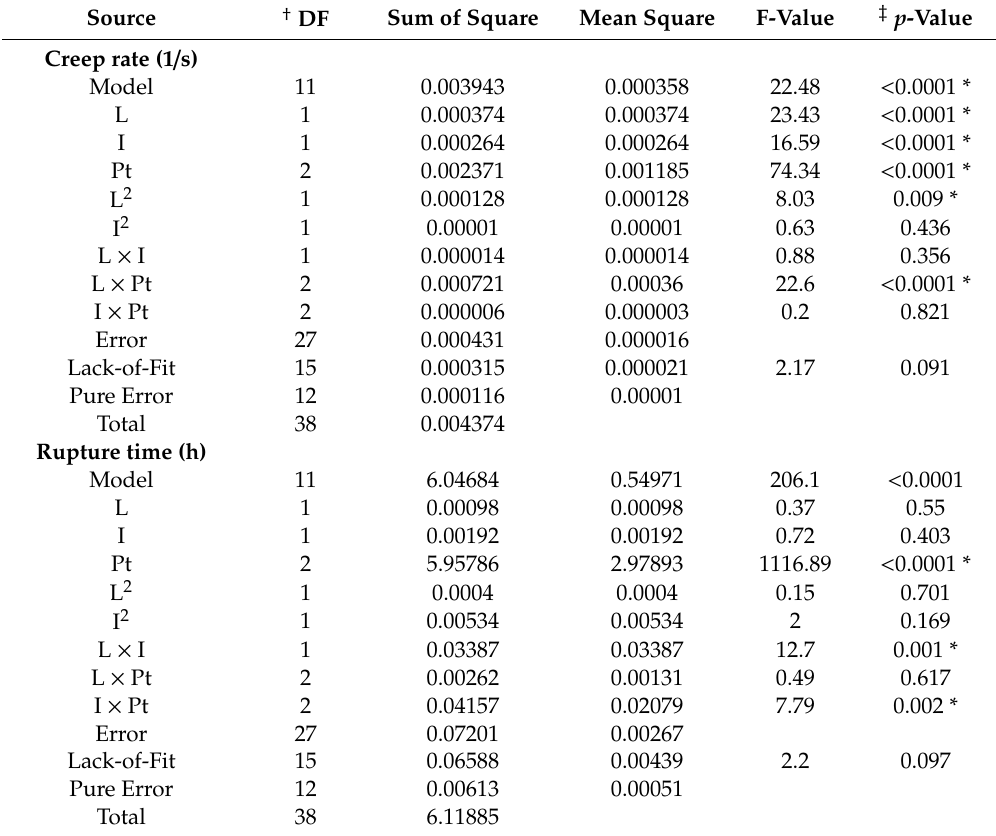
Table 4. ANOVA of central composite design for creep rate (1 / s) and rupture time